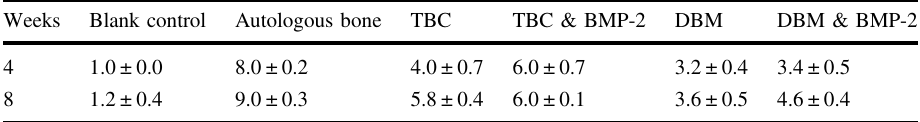
Table 2 Histological scoring of femoral condyle repair